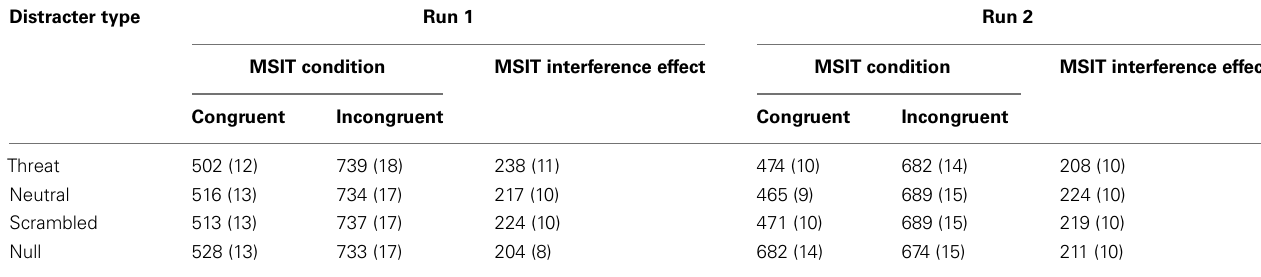
Table 6 | Summary of RT data (in ms) in run 1 and run